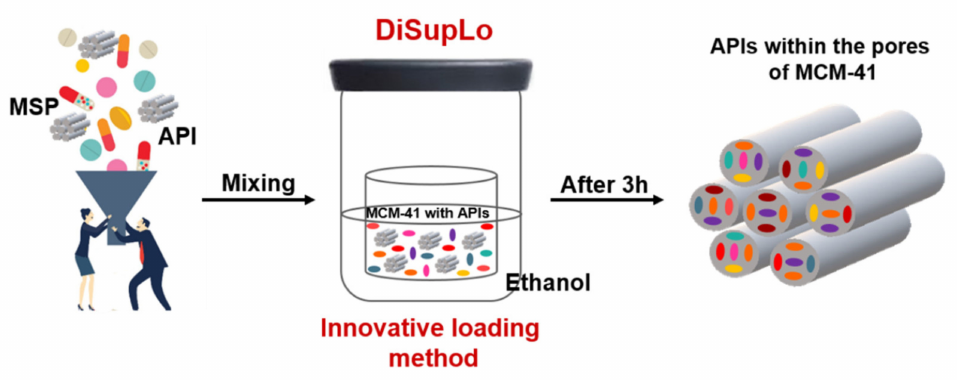
Figure 3. Schematic illustration of loading APIs into the pores of MSN using the DiSupLo method. Adapted with permission from [47]. Copyright 2020